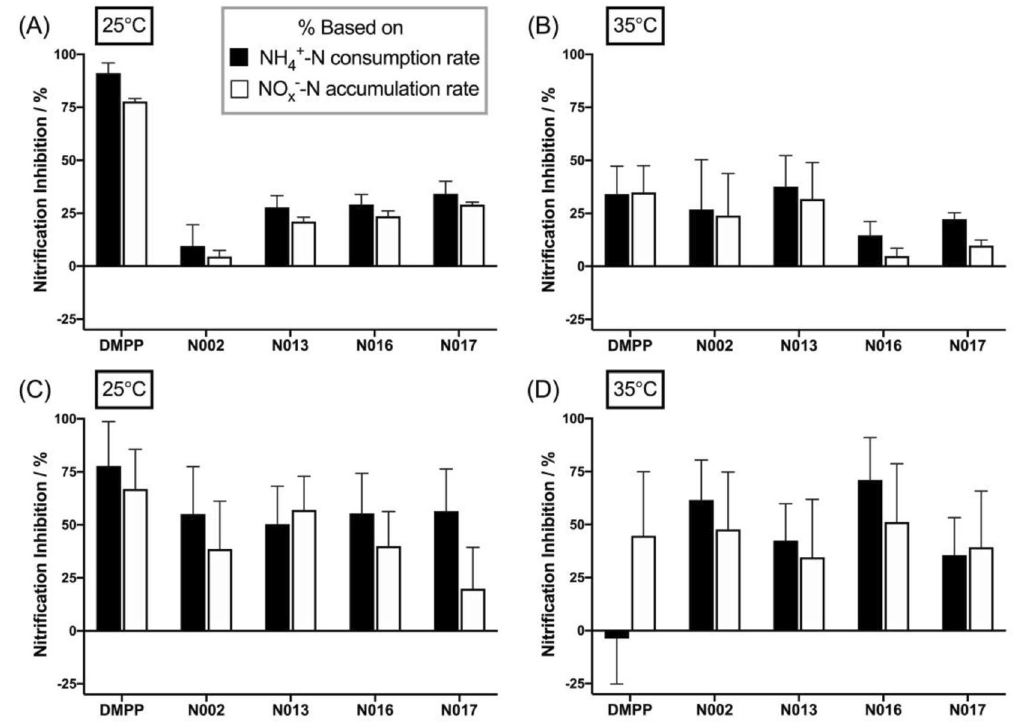
Figure 4. Nitrification inhibition (%) after 28-day incubation for selected inhibitor compounds; Horsham soil (pH 8.8) at ( A ) 25 °C and ( B ) 35 °C, Dahlen soil (pH 7.3) at ( C ) 25 °C and ( D ) 35 °C. Inhibition calculated from NH 4 + -N consumption rate (black filled bars) and from NO x – -N accumulation rate (white filled bars). All samples were treated with the fertiliser (NH 4 ) 2 SO 4 at a rate of 100 mg N kg -1 . Inhibitor application rates are 10 mol% of applied fertiliser N for all treatments. Data show the mean values (n = 3), errors are standard errors of the mean. Full data is provided in Tables S10 and S11 in the